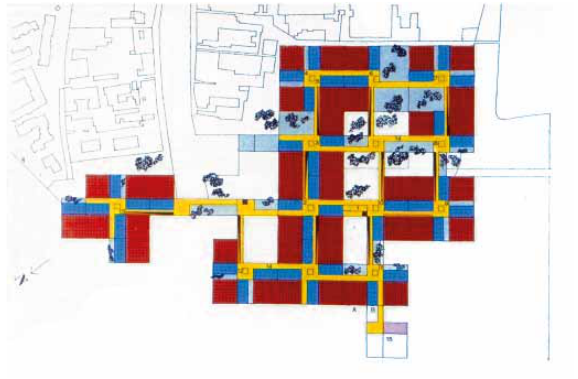
fig. 16. Venice Hospital – layout Plan and urban form